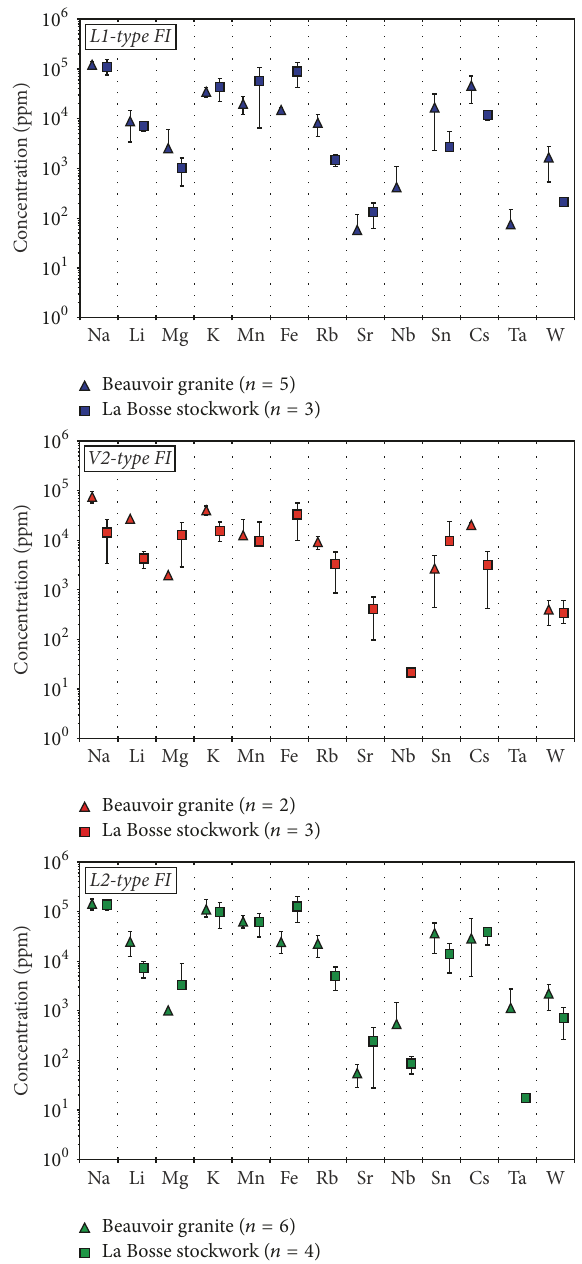
Figure 12: Minor and trace elements contents in L1-, V2- and L2-types fluid inclusions (FI) from the Beauvoir granite and the La Bosse stockwork determined by LA-ICPMS. The values and error bars correspond, respectively, to the averages and standard deviations of the concentrations determined by LA-ICPMS for each fluid inclusion